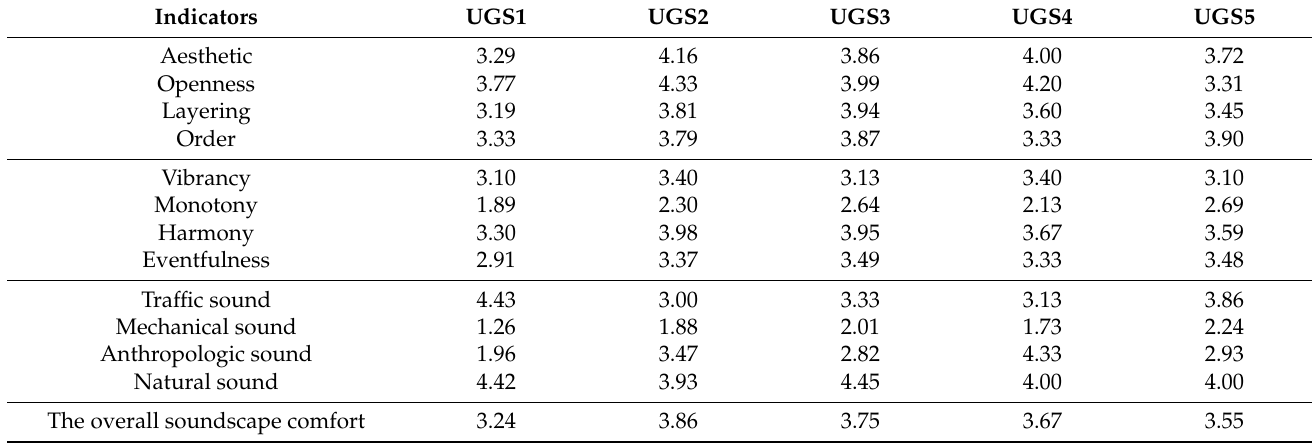
Table 3. The arithmetic average of perceptive evaluation in the five study sites.